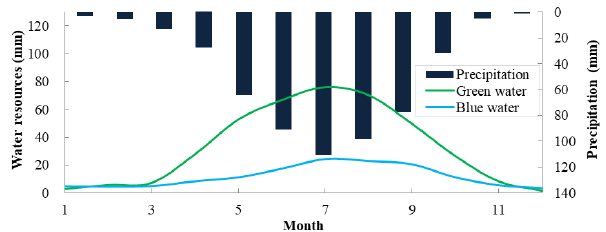
Figure 5. The intra-annual variability of the blue water and green